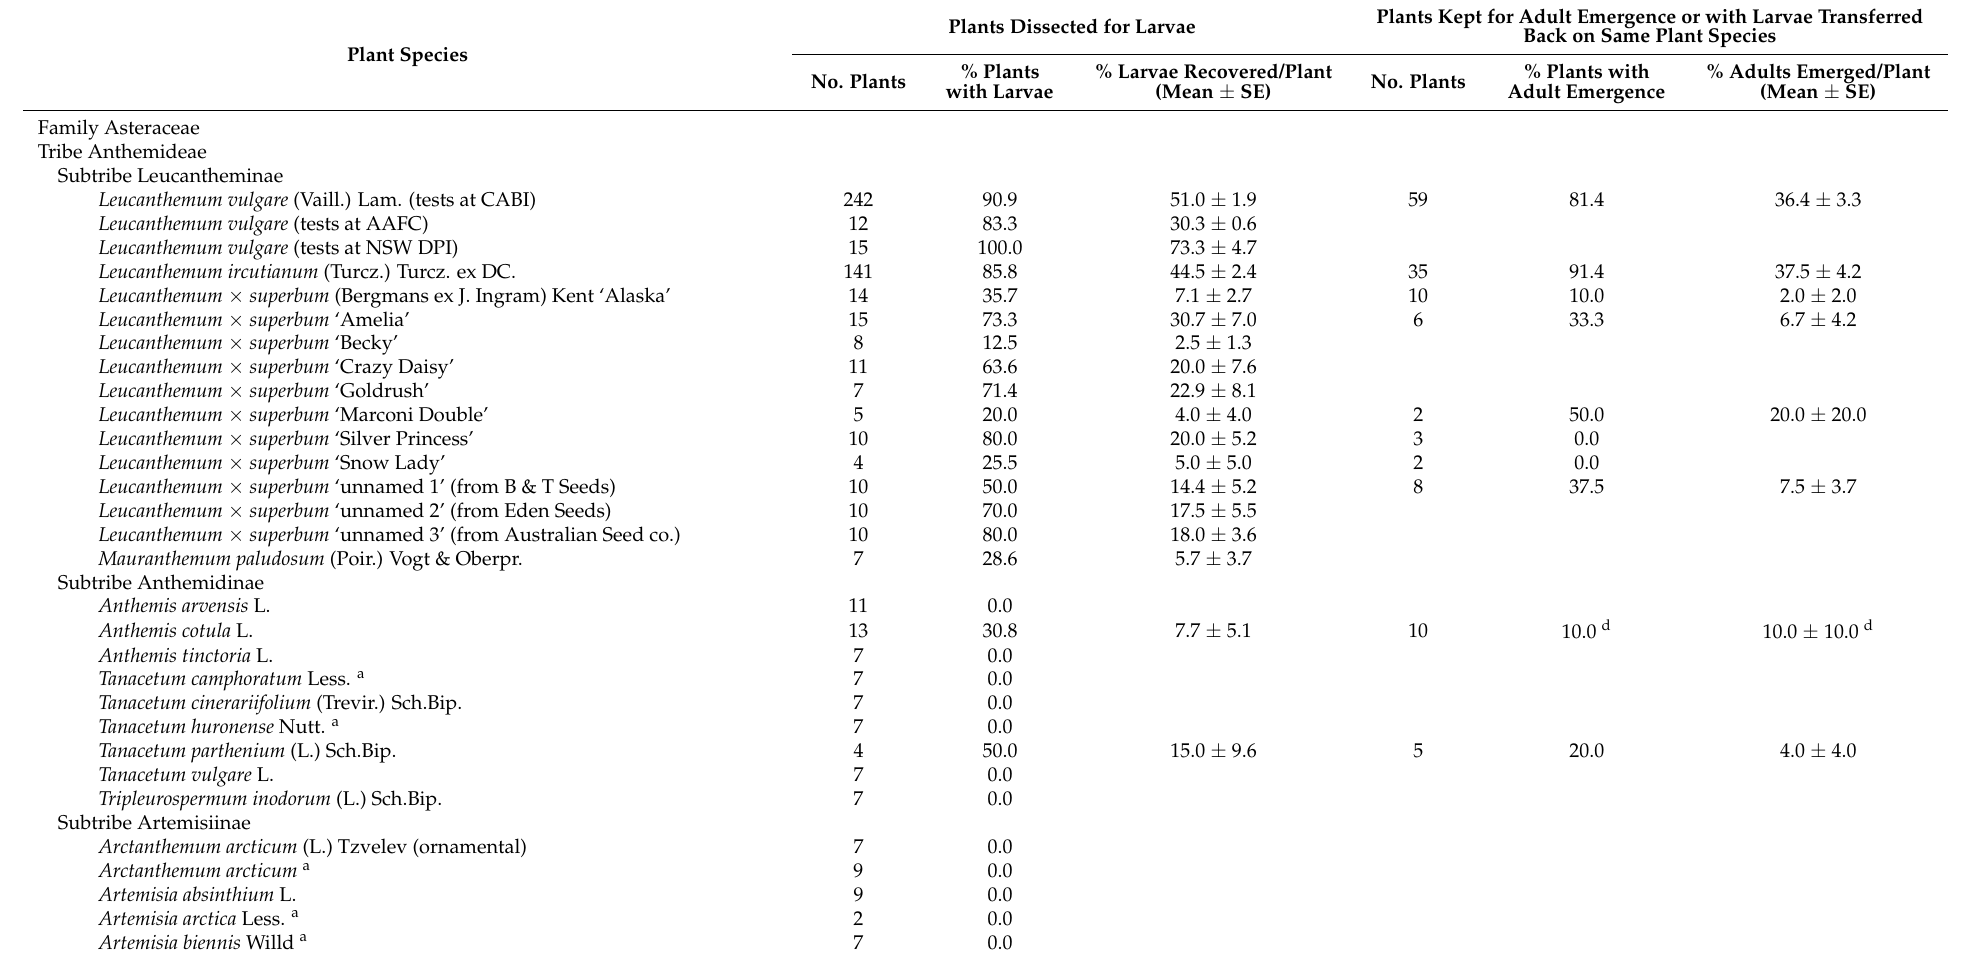
Table 1. Results of no-choice larval development tests with Dichrorampha aeratana conducted from 2011 to 2021. Plants were infested with five larvae in spring and either dissected for larvae in autumn or kept for adult emergence in the following spring. In addition, a subset of the larvae found on non-target and target plants were transferred onto new plants of the same plant species, which were then checked for adult emergence the following